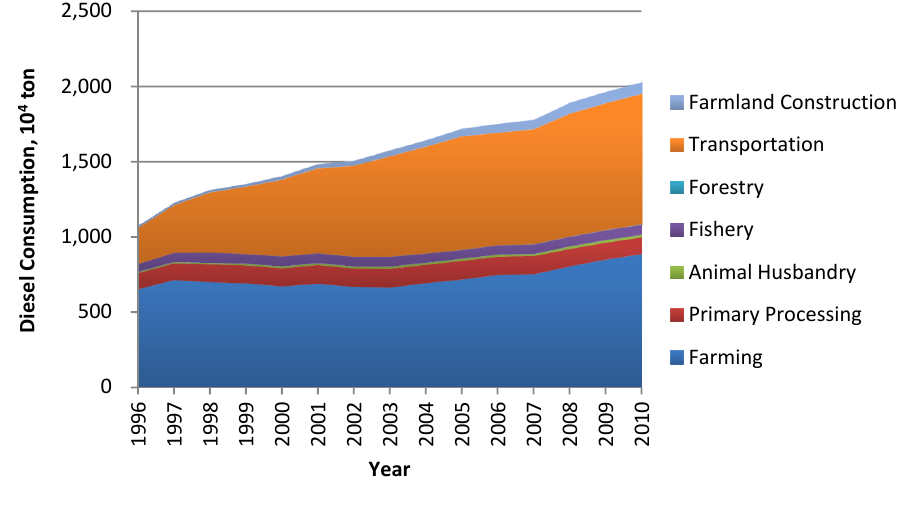
Figure 9. Diesel flows of the agriculture in China.